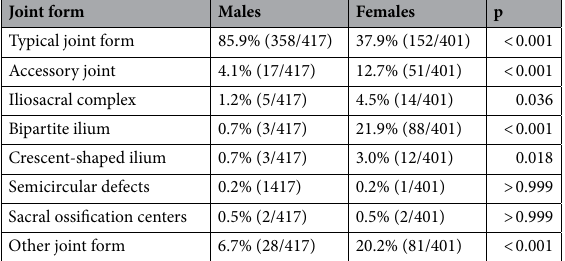
for different anatomical variants, specifically for the typical anatomical form, the accessory joint, and the bipar- tite iliac joint plate, as other variants were very rare. A graphical summary of the frequency of sclerosis in patients with different joint forms is given in Fig. 3. In patients with typical joint anatomy, sclerosis did not show a significant predilection for any region with an overall low occurrence of < 5% in all regions. In patients with an accessory joint, sclerosis was most pronounced in the dorsal and caudal portions of both ilium and sacrum—these differences were statistically significant. Patients with a bipartite iliac bone plate exhibited sclerosis mainly in the ventral cranial part of the ilium and on the right side, their frequency was significantly higher (11/91; p = 0.005). Distribution of osteophytes also differed between patients with different joint forms. Ventral osteophytes were seen in 30.2% (154/510) of patients with a typical joint form and in 35.3% (24/68) and 14.3% (13/91) of patients with accessory joints and bipartite bone plate respectively—the difference in frequency was statistically significant (p = 0.048). Dorsal osteophytes were significantly (p < 0.001) more common in patients with accessory joints (58.8%; 40/68) and bipartite iliac bone plate (53.8%; 49/91) than in those with a typical joint form (27.8%; 142/510). Joint space alterations were seen in 9.6% (49/510) of patients with typical joint form, 16.2% (11/68) of patients with an accessory joint and 4.4% (4/91) of patients with a bipartite bone plate. Imaging examples from the study cohort are provided in Fig. 4.